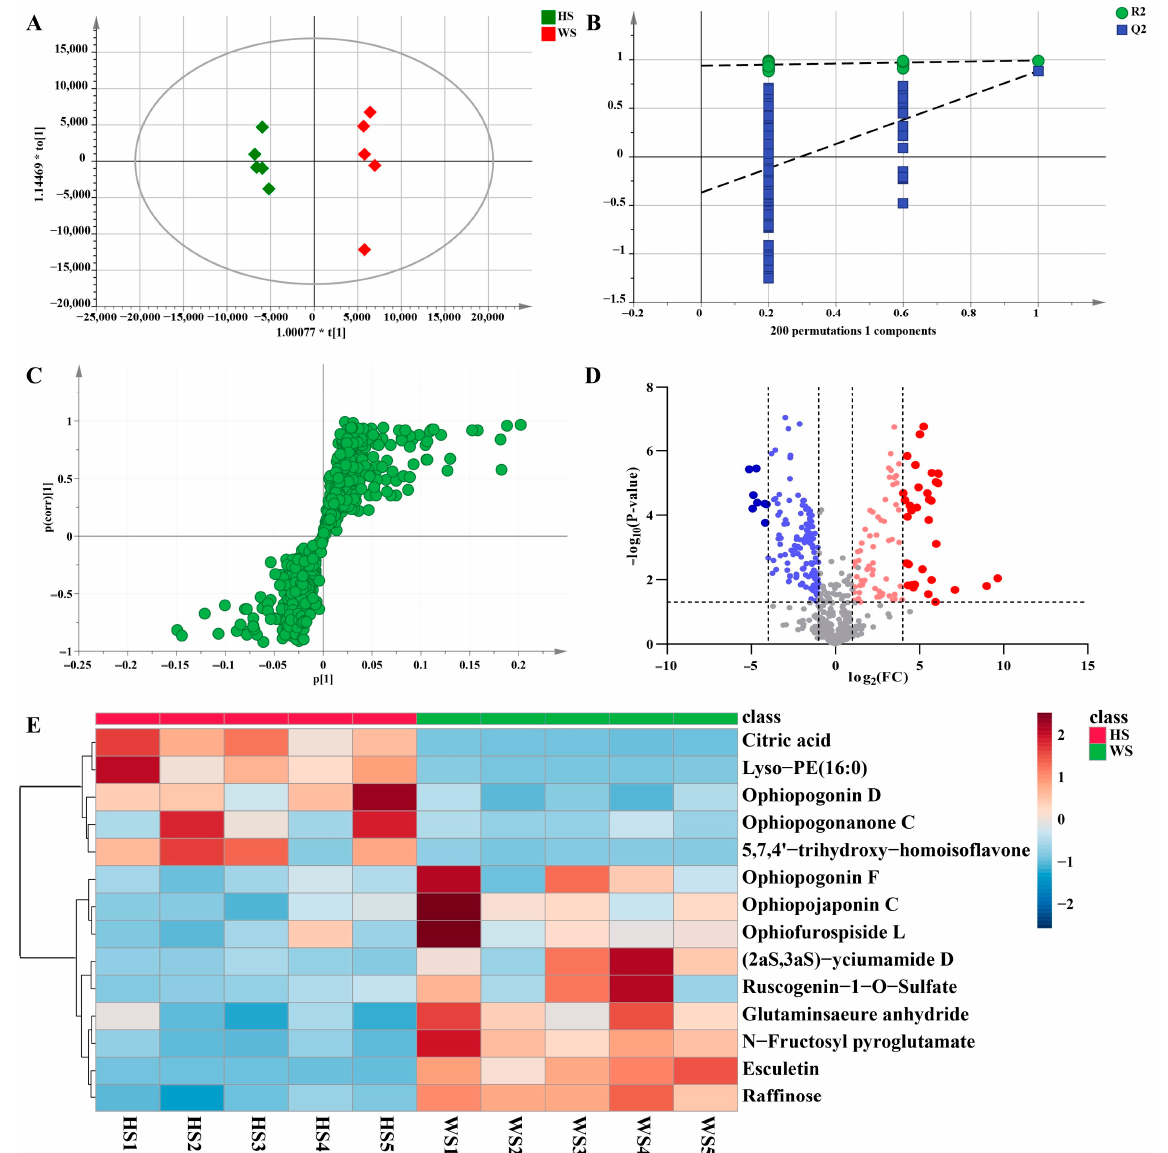
Figure 7. Multivariate statistical analysis result of HS and WS groups: OPLS-DA ( A ) score plots and OPLS-DA model permutation test ( B ), S-plot ( C ) and Volcano plots ( D ), ( C , D ) were used to explore markers in HS and WS, the heatmap of potential chemical markers ( E ). Lyso-PE (16:0):